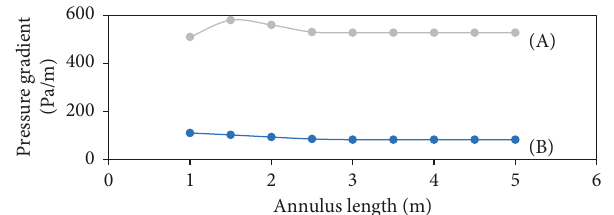
Figure 3: Length independence analysis (A) 75% eccentric, 150 RPM inner pipe rotation speed, and 400 kg/min flow rate; (B) concentric, stationary inner pipe, and 200kg/min flow